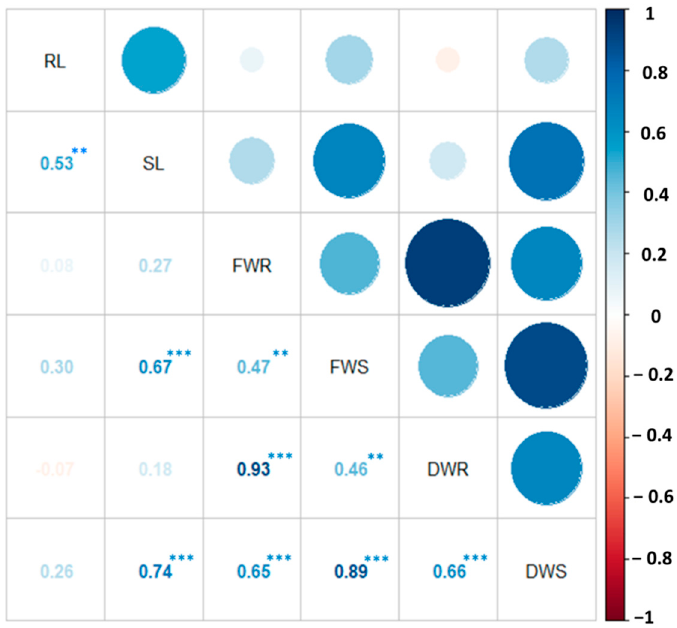
Figure 4. Correlation analysis among phenotypic traits of chickpea genotypes grown in 120 µM Al concentration. RL: root length; SL: shoot length; FWR: fresh weight roots; FWS: fresh weight shoots; DWR: dry weight roots; DWS: dry weight shoots. Significance codes: ‘***’ 0.001; ‘**’ 0.01.